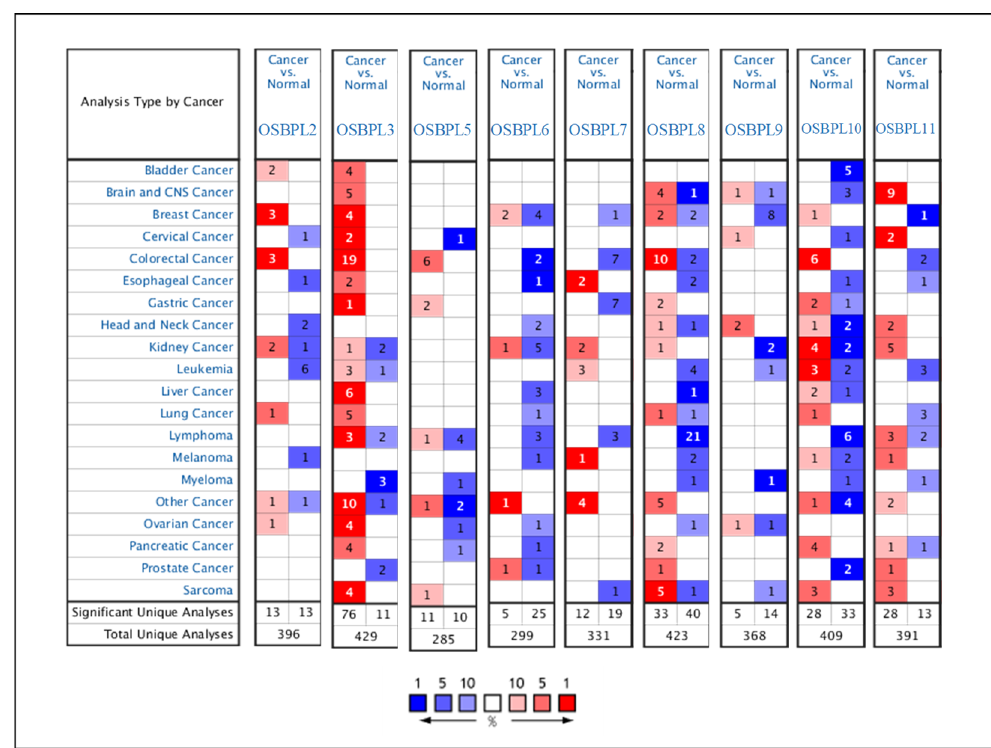
Figure 1. Gene transcript expressions of proteins secreted by oxysterol-binding protein (OSBP)-like (OSBPL) family members in different types of cancers from the Oncomine database. Statistically significant differences in the mRNA overexpression of OSBP family genes are shown in red, and differences in downregulation are shown in blue.